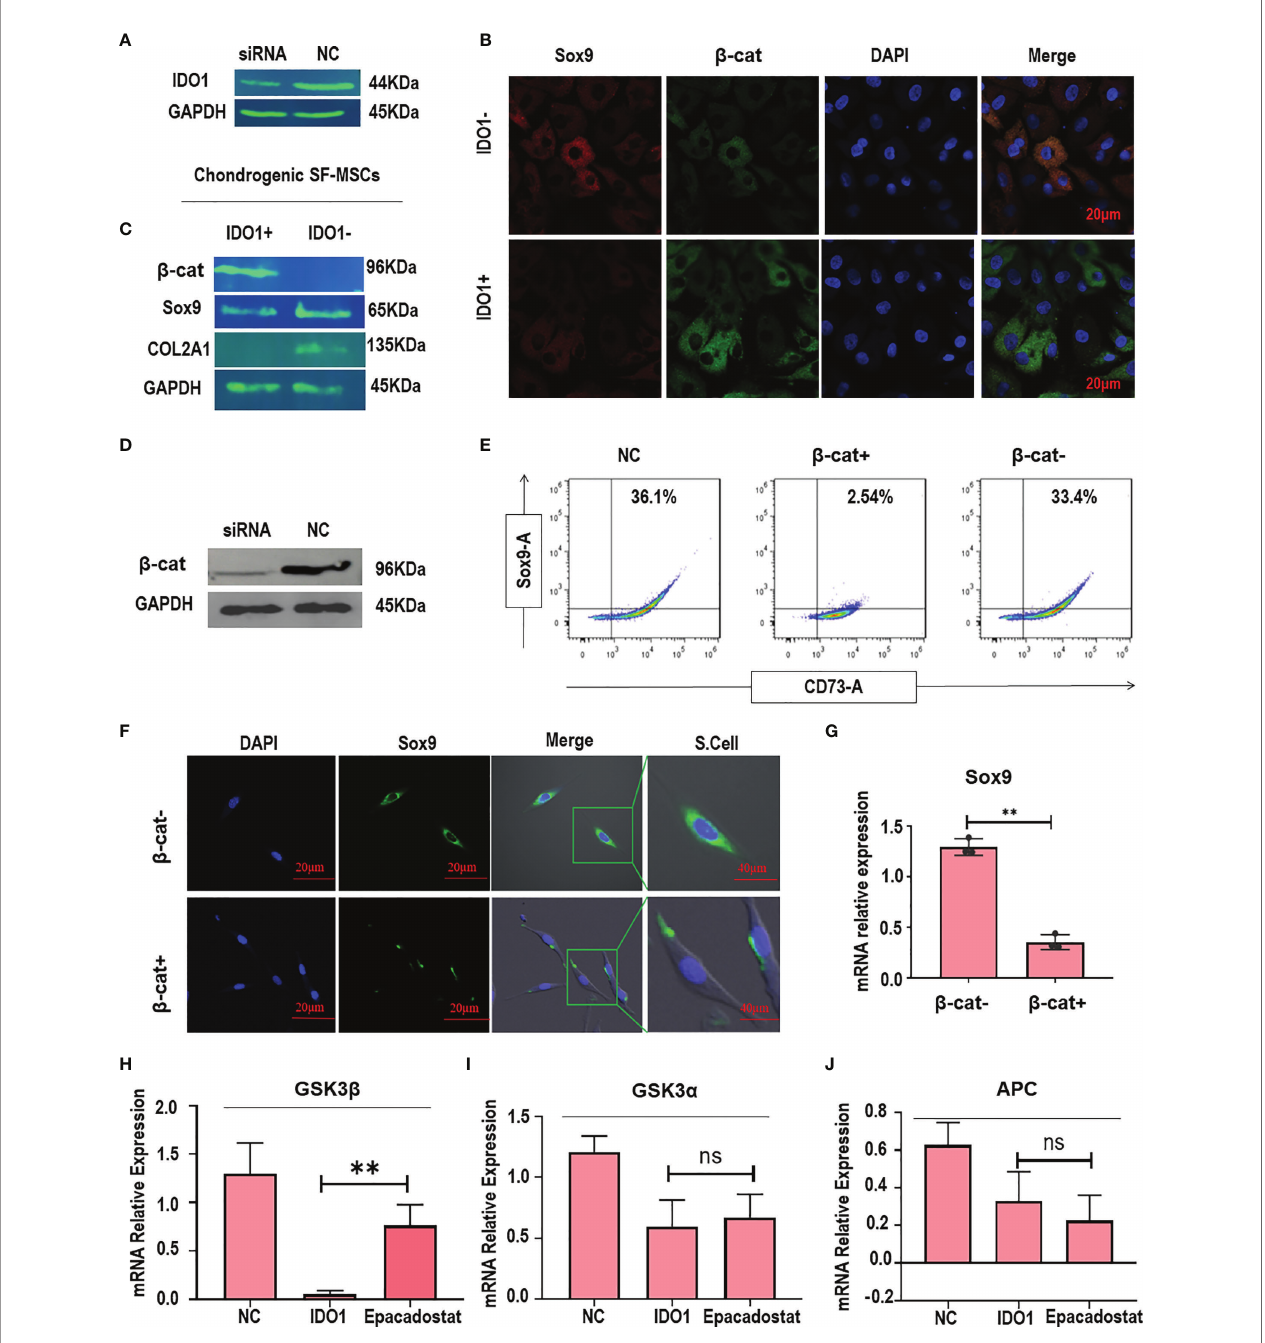
FIGURE 3 | IDO1 regulates the expression of Sox9 through activating b -catenin in the MSCs. (A) Silencing of IDO1 using siRNA in the MSCs. (B) The immuno fl uorescence expression of Sox9 and b -catenin in the IDO1 silenced cells compared to IDO1-positive cells. (C) The expression of Sox9, COL2A1, and b - catenin by western blot in the IDO1 knocked cells compared to active IDO1. (D) The knocking down of b -catenin in the SF-MSCs using siRNA transfection. (E) The expression of Sox9 under b -catenin silencing in the SF-MSCs compared to active b -catenin using fl ow cytometry. (F) The expression of Sox9 under b -catenin silencing using confocal laser microscopy. (G) The expression of Sox9 under b -catenin silencing by qPCR. (H) The expression of GSK3 b in the MSCs under the effect of IDO1 and Epacadostat compared to the NC group. (I) The expression of GSK3 a in the MSCs under the effect of IDO1 and Epacadostat compared to the NC group. (J) The expression of APC in the MSCs under the effect of IDO1 and Epacadostat compared to the NC group. ** p < 0.01 vs NC group. ns, no signi fi